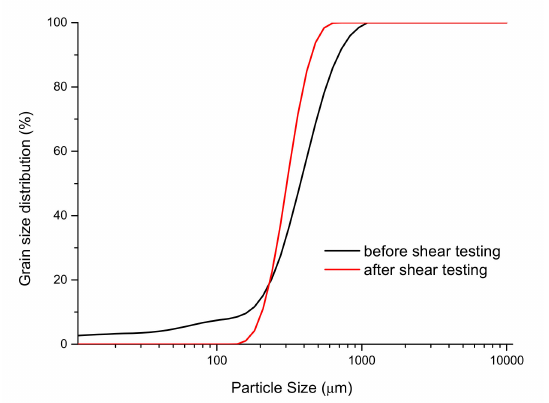
Figure 8. Grain size distribution curves of 40–60 mesh particle sizes before (black line) and after (red line) shear